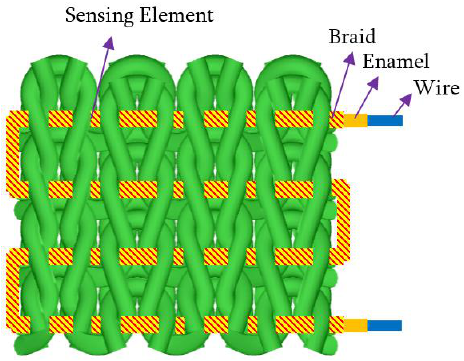
Figure 1. A conceptual illustration of a temperature sensing fabric (TSF) embedded with braided- enamelled sensing element in double-layered knitted structure.